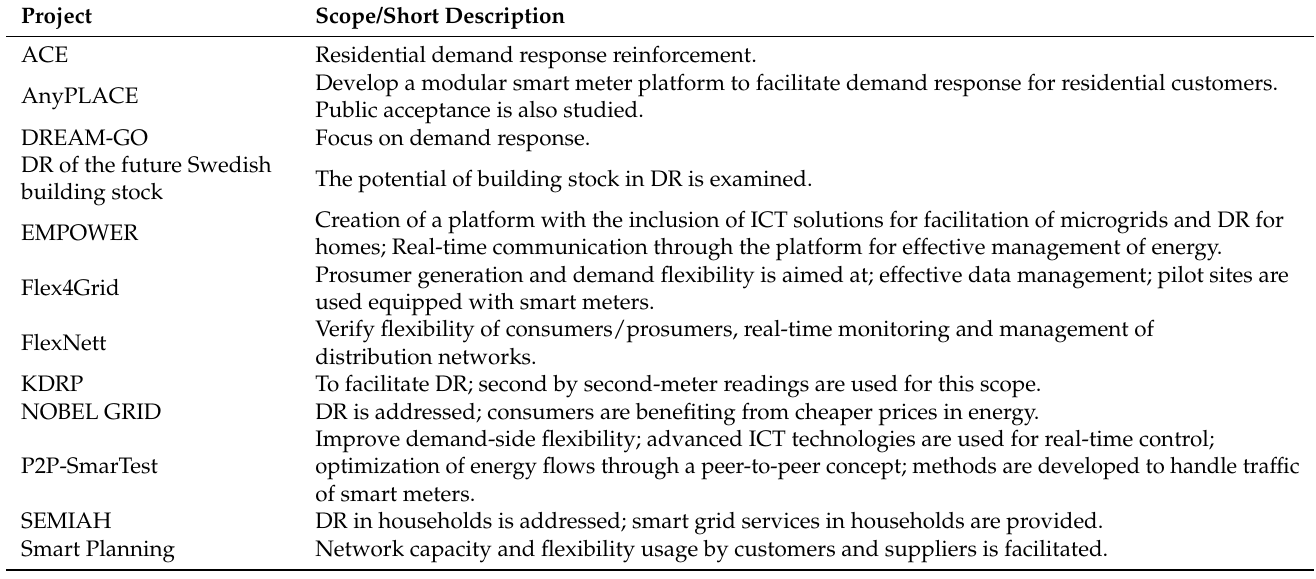
Table 6. Demand Response/Flexibility